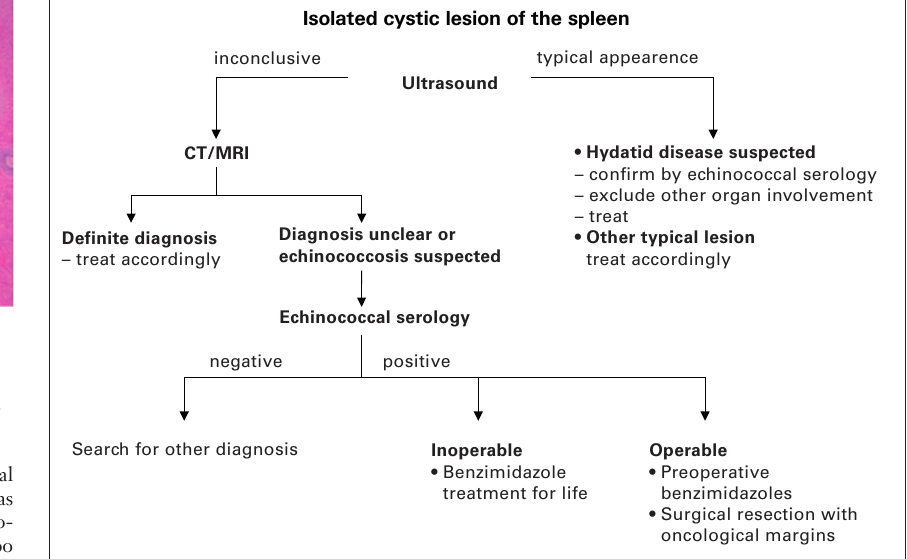
Decision diagram for isolated splenic